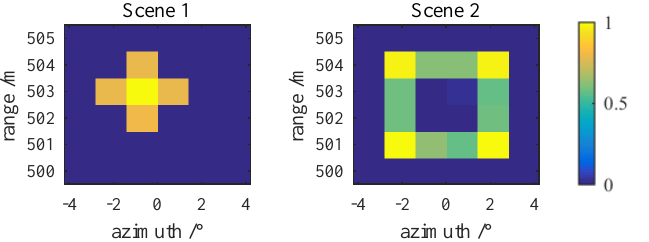
Figure 8. Image reconstruction results when the scattering points have different